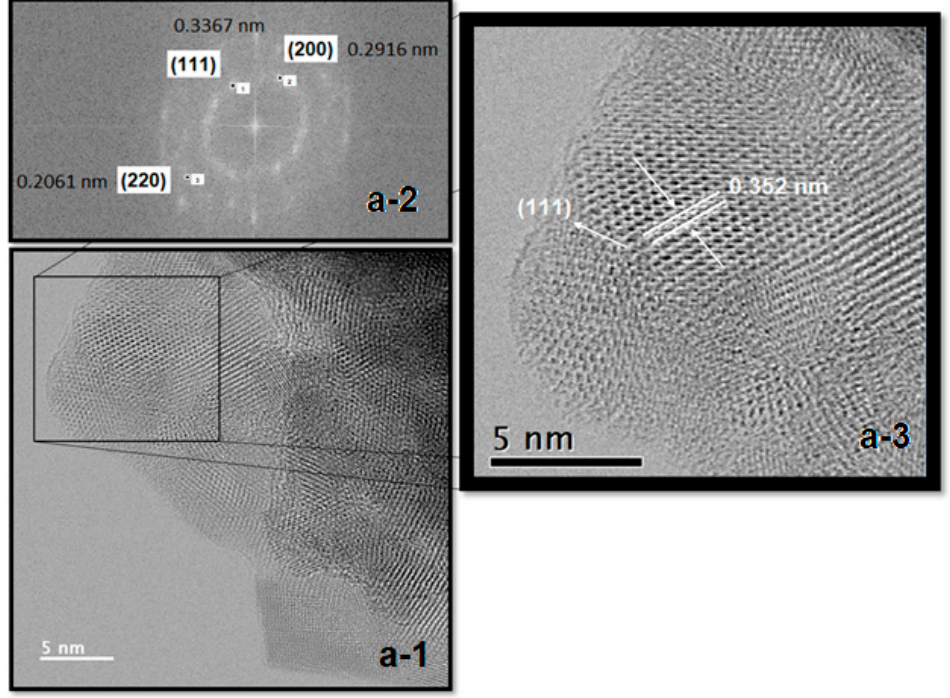
Figure 4. High-resolution transmission electron microscopy (HRTEM) patterns of pure CdS. ( a-1 ) The growth patterns (randomly oriented polycrystalline material), ( a-2 ) the selected portion shows the Fourier Transformed from a-1, and ( a-3 ) shows the interplanar spacing between planes.